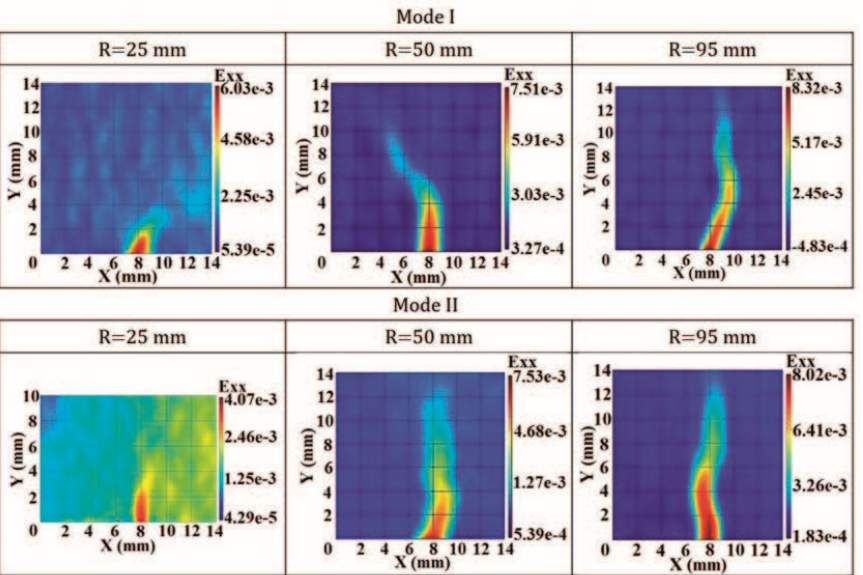
Figure 6. The schematic diagram of the evolution of FPZ with the increasing of load. Re- printed/adapted with permission from Ref. [145]. Copyright 2020, Elsevier.